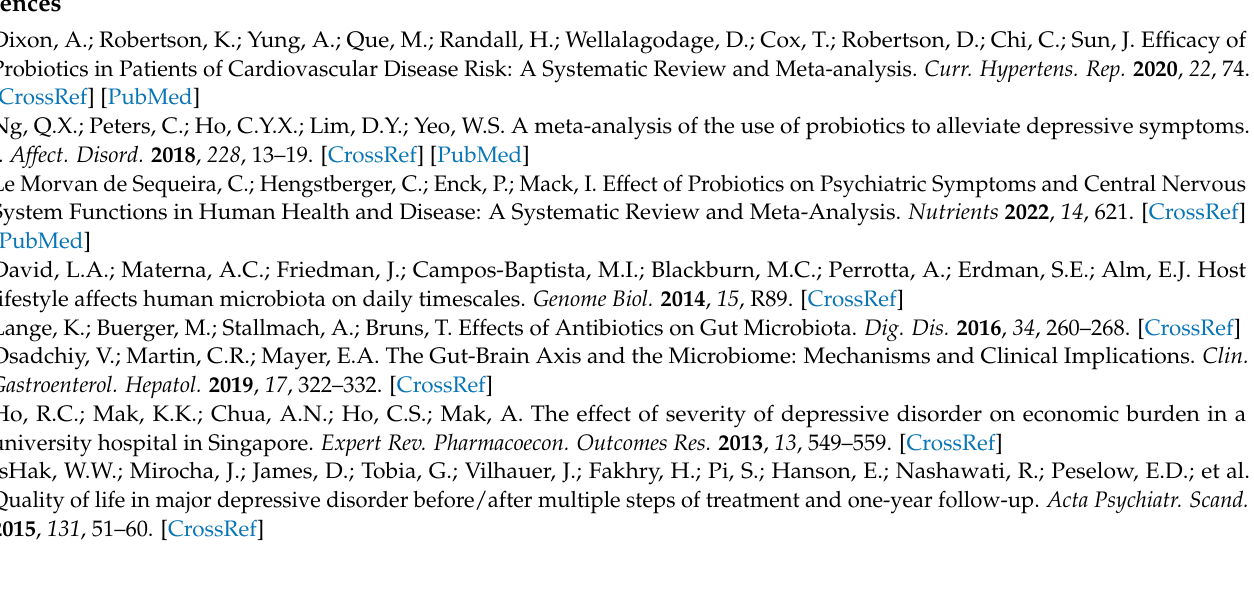
databases. Figure S1: Forest plot showing the standardized mean difference for change in depressive rating scales, post-probiotic